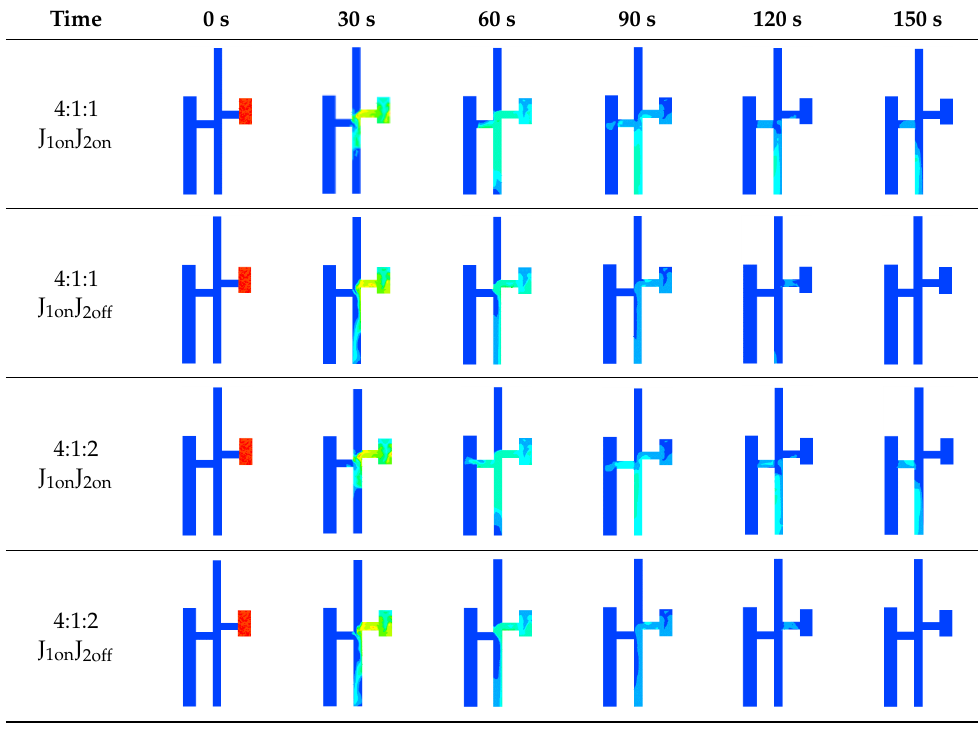
Table 13. CO emission process (dirty air source from work face 1).